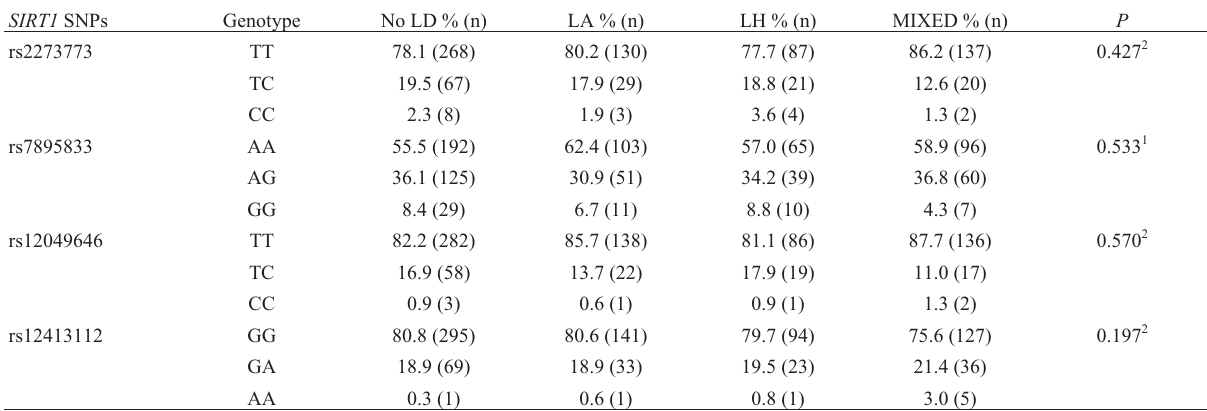
Table 3 - Comparison of genotype frequencies of rs2273773, rs7895833, rs12049646, rs12413112 genetics variants in SIRT1 among lipodystrophy sub- types. SIRT1 SNPs